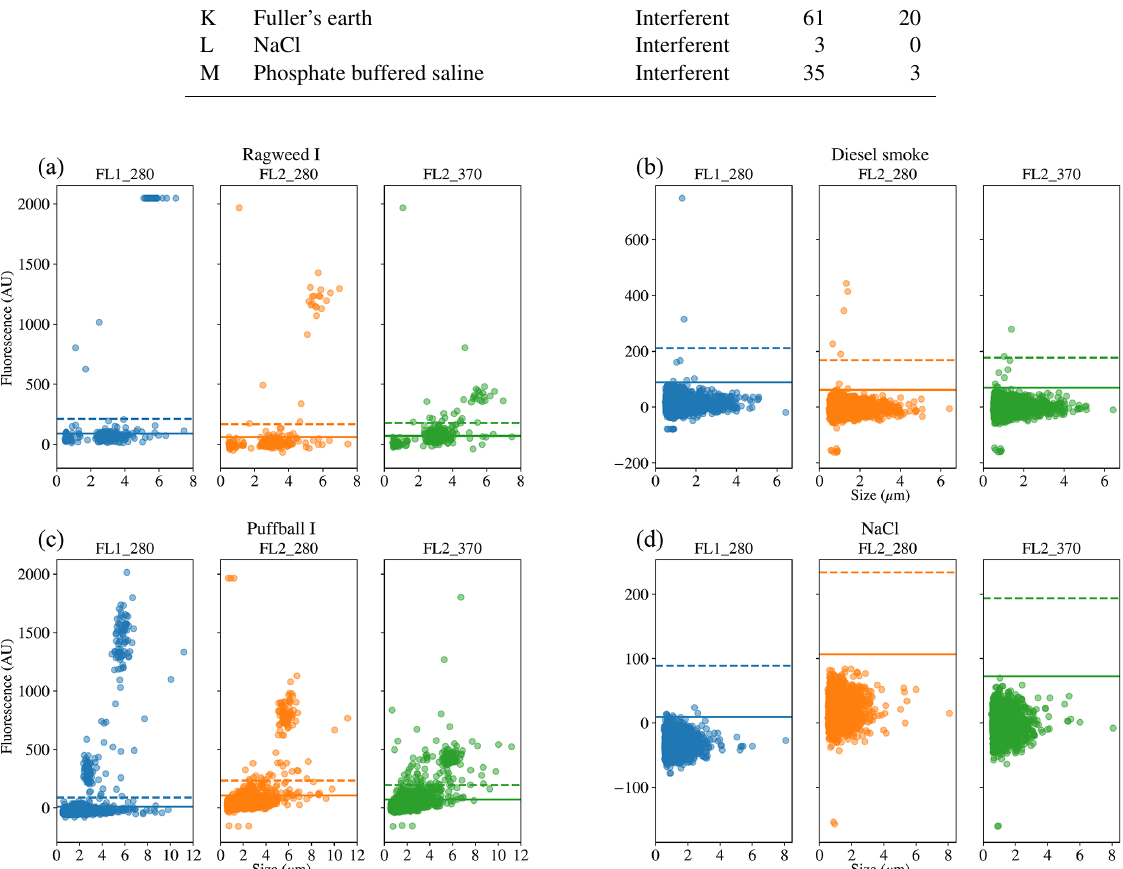
Figure 8. Scatter plots of fluorescence vs. size for four of the samples. Two of the samples were collected in 2008 (a, b) and two were collected in 2014 (c, d) ; two are biological (a, c) and two are non-biological (b, d)